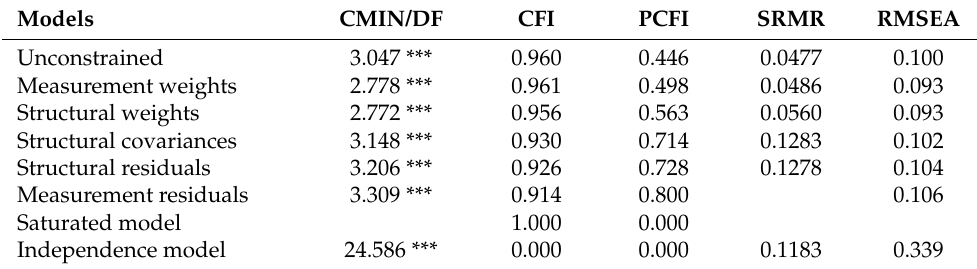
Figure 1. Multigroup analysis of the moderation model for the overall sample. Summary of estimates from authoritarian and permissiveness, triangulation, and conflict to child adjustment (SDQ as a latent variable). Note: Model χ 2 /df = 5.448 ( p < .01); comparative fit index (CFI) = 0.97; Tucker–Lewis index (TLI) = 0.94; standardized root mean square residual (SRMR) = 0.03; root mean square error of approximation (RMSEA) = 0.10 (90% CI [0.08, 0.13]). For CFI and TLI, a value larger than 0.9, SRMR values below 0.08, indicated good model fit. Table 2. Results of multigroup analyses: standardized maximum likelihood estimate.